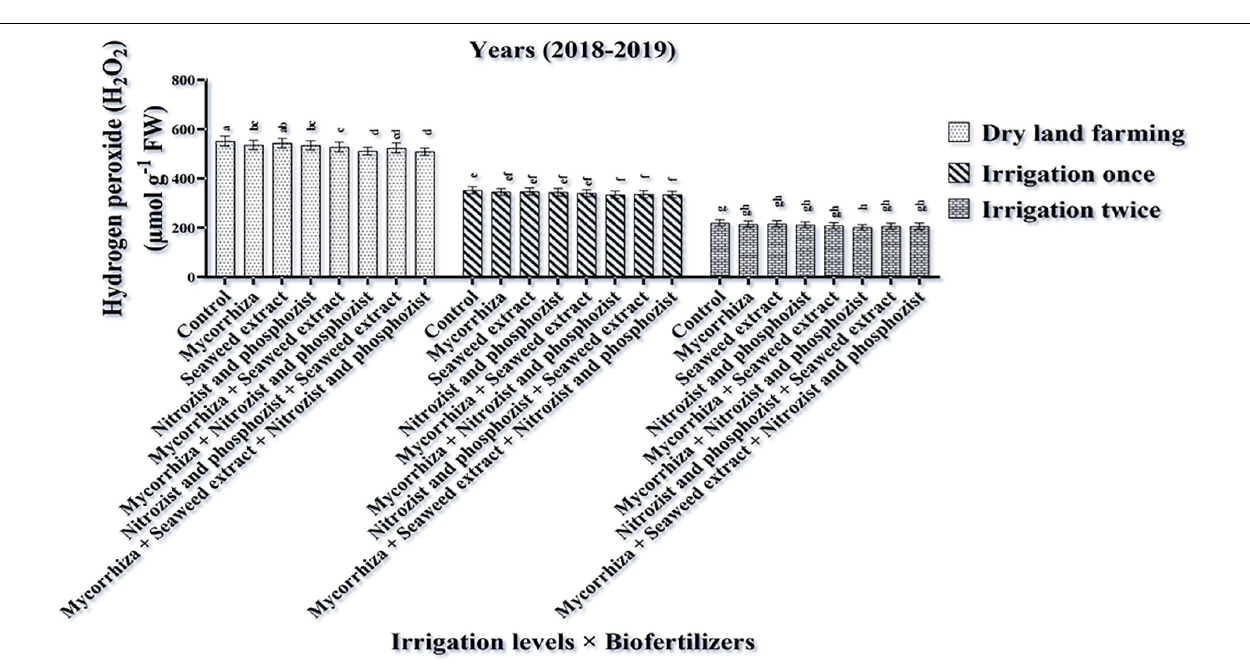
has a higher RWC. Increasing the RWC of the leaves